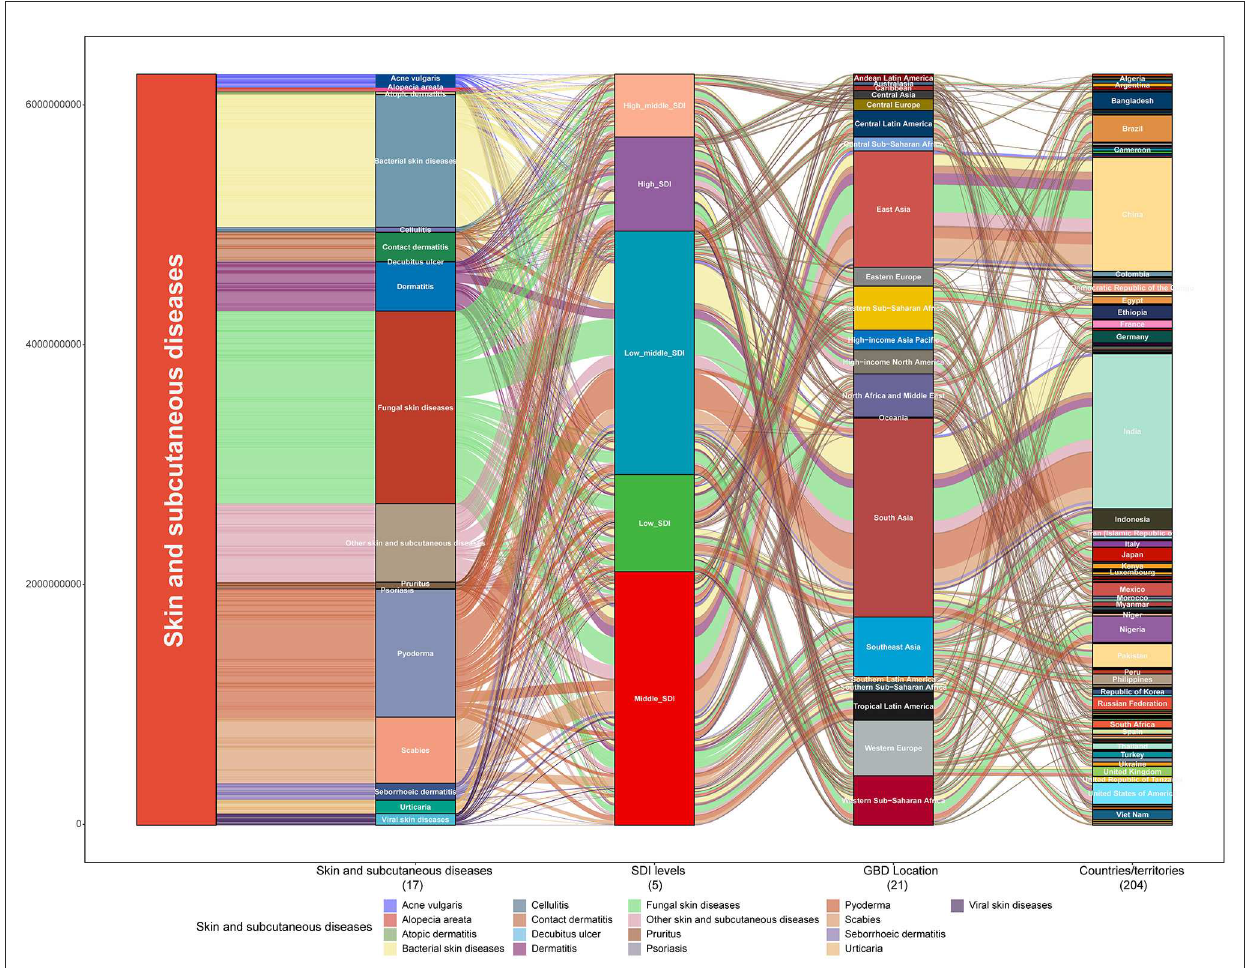
FIGURE6 Skin and subcutaneous disease burden in 2019. Distribution of new cases of each skin and subcutaneous disease at the global level, showing different SDI levels, different GBD regions (21), and 204 countries/territories in 2019. GBD, Global Burden of Disease; SDI, sociodemographic